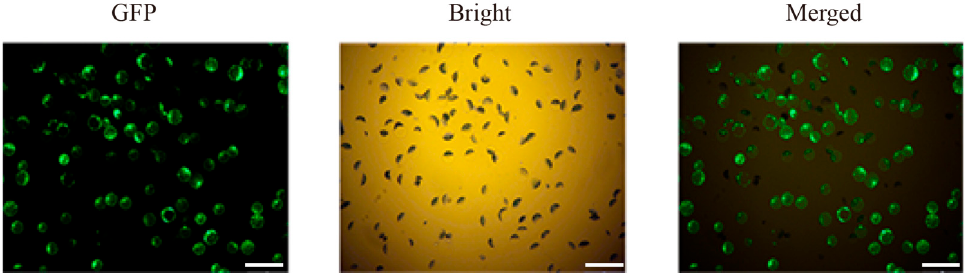
Figure 6. Protoplast of wheat transformed from green fluorescent protein (GFP). Bar = 100 μ m.